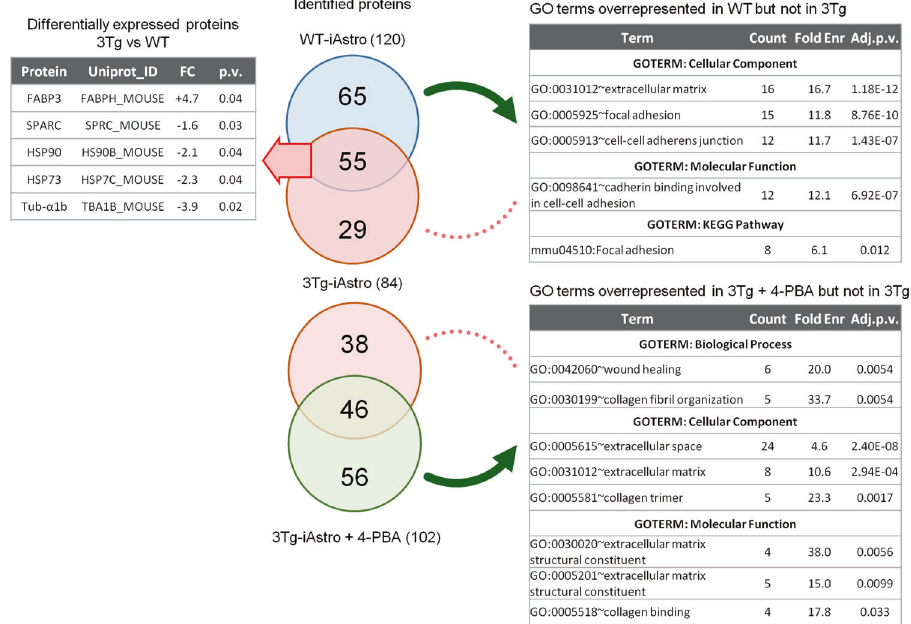
Fig. 8 Proteomic analysis of WT- and 3Tg-iAstro secretome. ACM (10 ml) was collected from 48 h culture of WT-iAstro, 3Tg-iAstro and 3Tg- iAstro cells treated with 4-PBA (3 μ M, 48 h). Proteins were precipitated by TCA and processed as described in Methods section. 120, 84 and 102 proteins were identi fi ed in WT-iAstro, 3Tg-iAstro and 3Tg-iAstro + 4-PBA ACM, respectively. Protein quanti fi cation of 3Tg-iAstro vs WT-iAstro ACM returned fi ve differentially regulated proteins (1.3 fold change cut-off, p < 0.05) (left upper table). Gene ontology analysis of proteins, unique for WT-iAstro or 3Tg-iAstro + 4-PBA both compared with 3Tg-iAstro ACM, returned GO terms related to extracellular matrix, focal adhesion and cadherin binding overrepresented in both WT-iAstro and 3Tg-iAstro + 4-PBA, but not in 3Tg-iAstro cells (right bottom